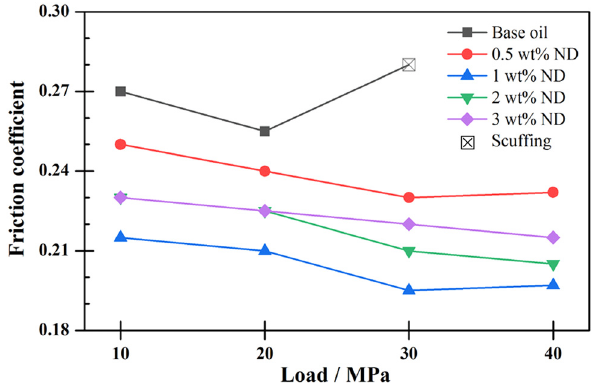
Figure 3: Variation of the friction coe ffi cient between the Cr liner and the CrN - coated piston ring.